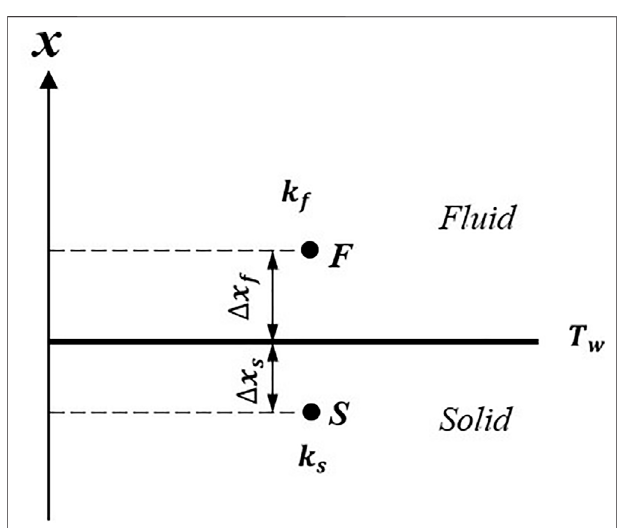
FIGURE 9 | Temperature variations at fl uid-solid